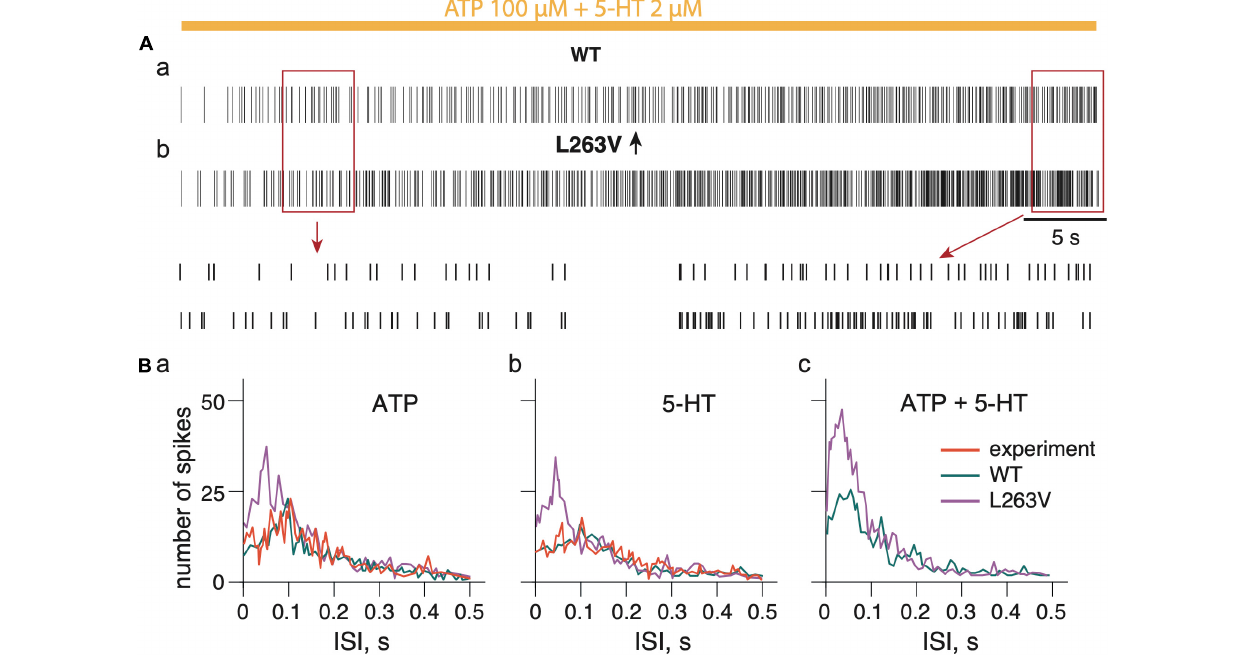
FIGURE 6 | Firing activity of whole trigeminal meningeal nerve induced by persistent ATP plus 5-HT. (Aa) Firing activity of Na V 1.1 WT nerve induced by combined ATP (100 µ M) and 5-HT (2 µ M) action. (Ab) Firing activity induced by combined ATP (100 µ M) and 5-HT (2 µ M) action on nerve with fibers expressing L263V Na V 1.1 mutant channels. Notice details of fitting in insets. (Ba) The distribution of the inter-spike intervals (ISI) during action of ATP, 5-HT (Bb) and combined ATP + 5-HT action (Bc). ATP signaling is limited by partial hydrolysis and 5-HT signals are reduced by specific